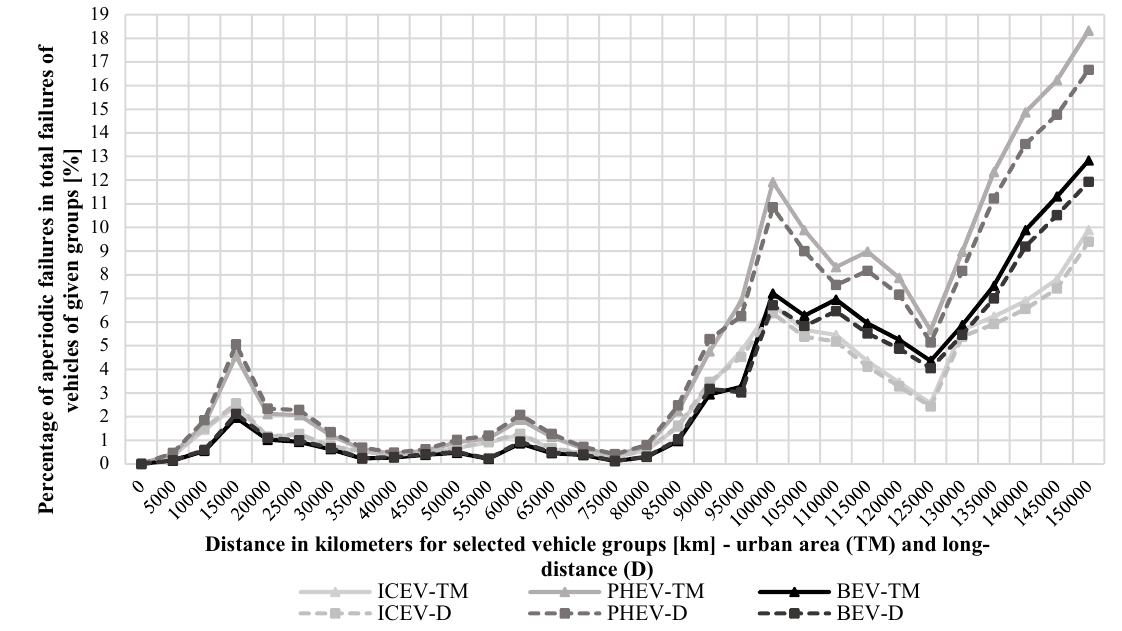
Figure 7. Distribution of aperiodic failures for a small city vehicle with ICEV, PHEV, and BEV propulsion for urban and long-distance speed profiles over a distance of 150,000 km.